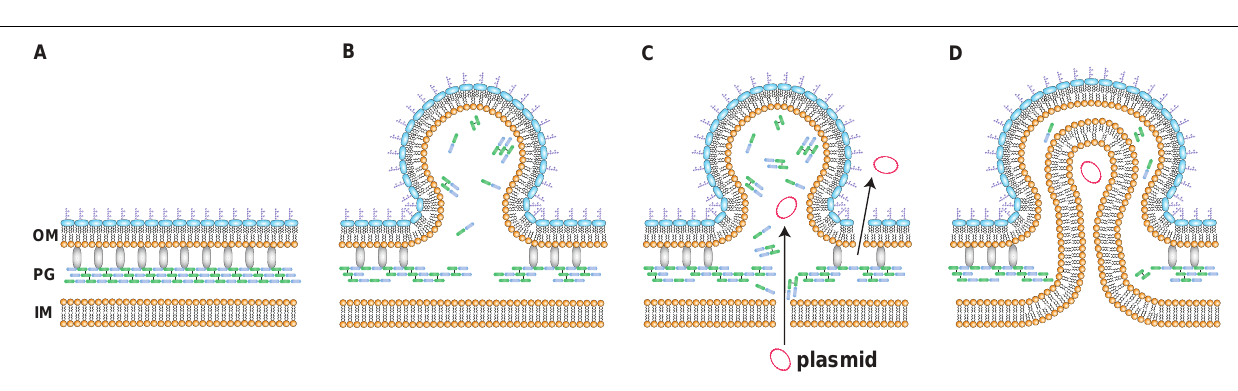
Frontiers in Microbiology |